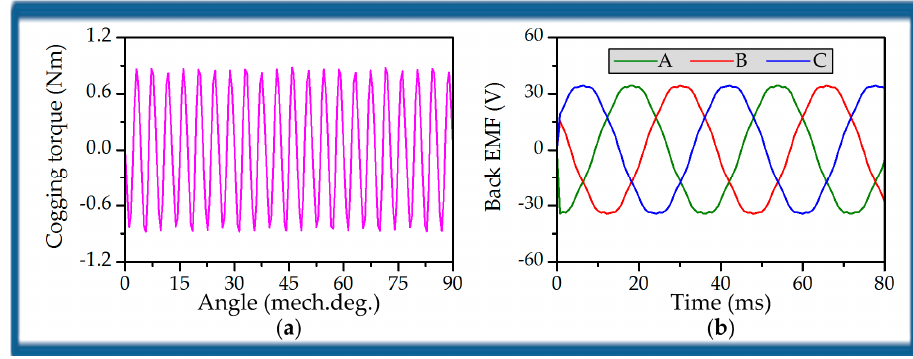
Figure 11. Proposed DPME machine: ( a ) Cogging torque; ( b ) Back EMF.